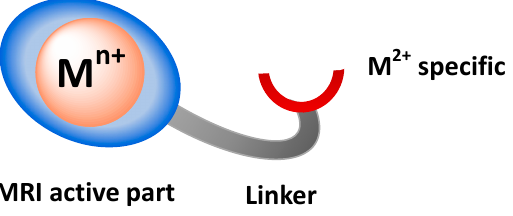
(Figure 2): a paramagnetic metal–ion complexing unit (MRI active part), an M 2+ complexing unit (specific to the cation being detected), with a linker between them. Figure 2. Design of cation responsive contrast agents.